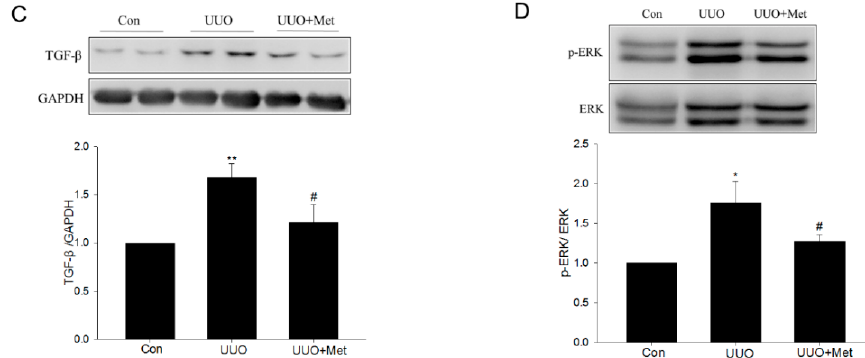
Figure 4. The effect of metformin on unilateral ureteral obstruction–induced transforming growth factor- β upregulation and ERK signaling activation. ( A , B ) The time course of transforming growth factor- β (TGF- β ) and p-ERK in unilateral ureteral obstruction (UUO) mice, at three and seven days, visualized by Western blotting; ( C , D ) The levels of TGF- β and p-ERK were analyzed by Western blotting after metformin treatment. Data are the mean ± SEM of six animals. * p < 0.05, ** p < 0.01 compared with control (Con); # p < 0.01 compared with UUO with vehicle (UUO). 2.3. ERK Inhibitor PD98059 Inhibited UUO-Induced TGF- β Upregulation and ECM Production Western blotting results showed that the upregulation of ECM proteins was suppressed by PD98059 administration in UUO mice (Figure 5A,B). Moreover, the upregulation of TGF- β was also inhibited by PD98059 (Figure 5C).